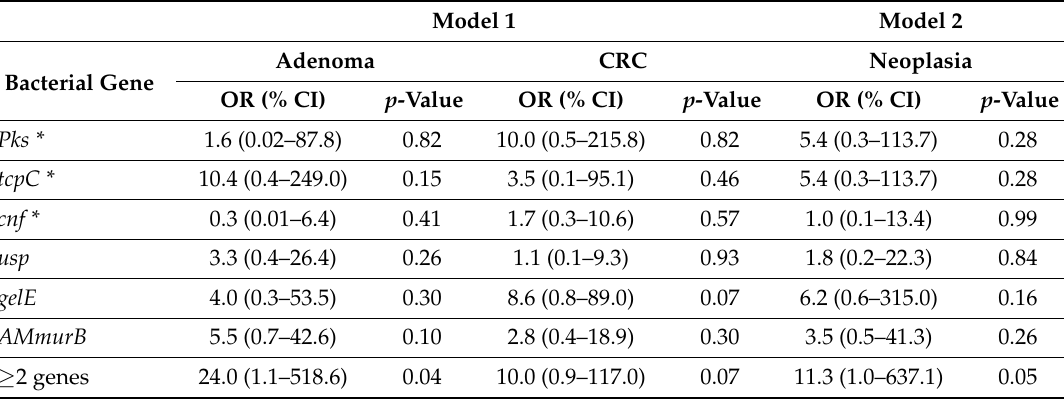
Table 5. Odds ratio (OR) estimation for the association between the presence of gut bacterial toxin genes in stool samples from individuals from Puerto Rico and colorectal neoplasia ( n =